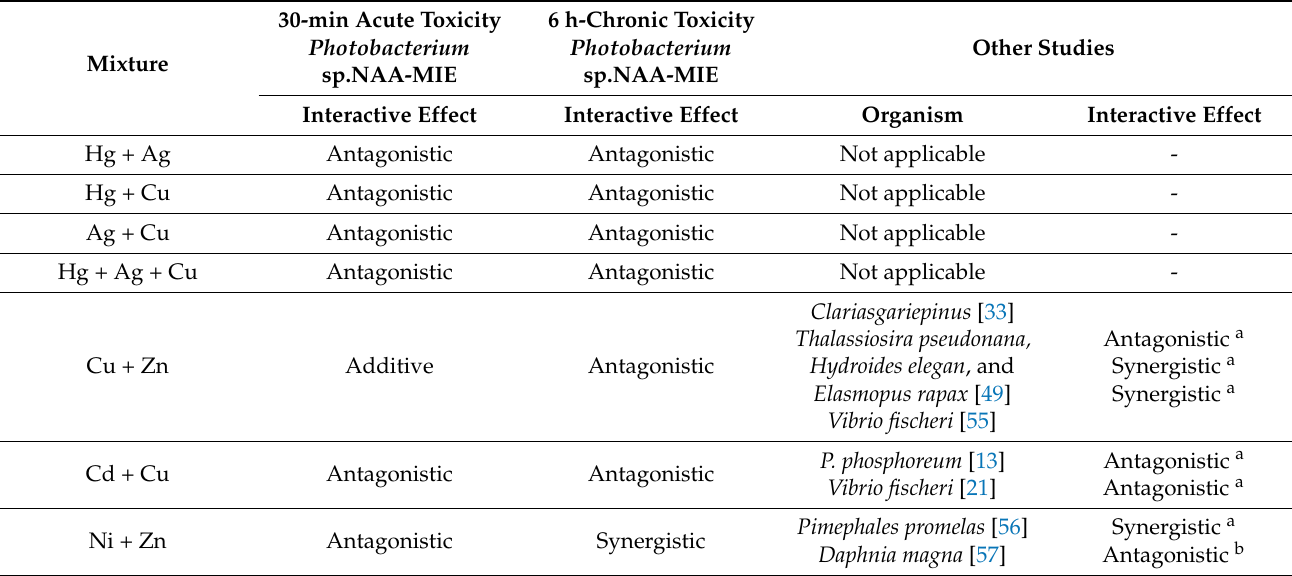
Table 9. Comparative metals mixture toxicity studies on Photobacterium sp.NAA-MIE with those reported by other investigators among different